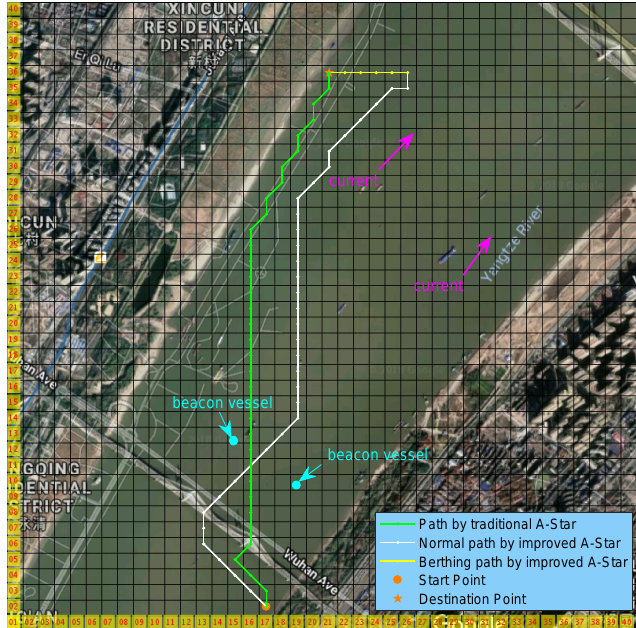
Figure 11. The path planned by the proposed A-Star algorithm in Wuhan waterway of Yangtze river.